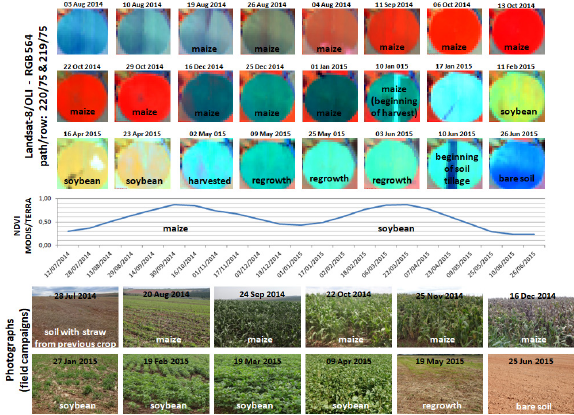
Figure 2. Field and satellite data of an area cultivated with crop rotation of maize followed by soybean. Source: Parts of the figure was adapted from Formaggio and Sanches (2017).